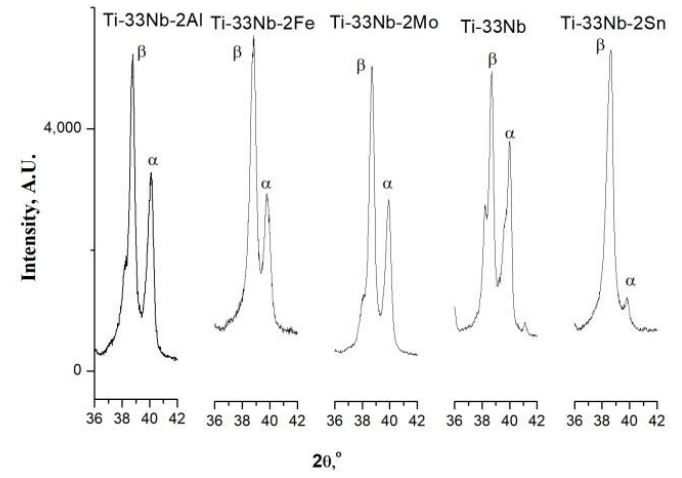
Figure 1. X-ray diffraction profiles of the furnace-cooled Ti-33Nb-2X (X = Al, Fe, Mo and Sn) alloys.